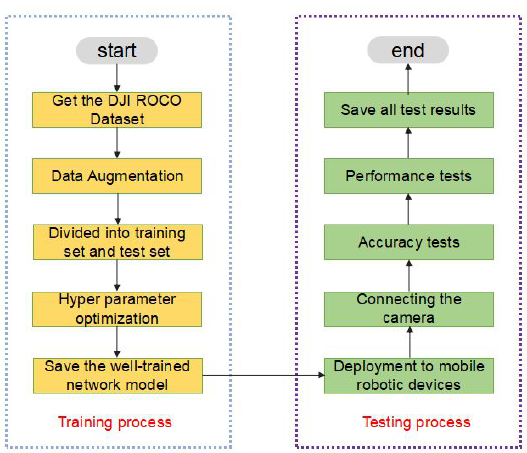
Figure 11. Experimental flowchart. The experimental process is divided into a training process and a testing process. The training process mainly includes the manipulation of the dataset, the tuning of pa- rameters, and the training of the model network. The testing process mainly consists of configuring the equipment and